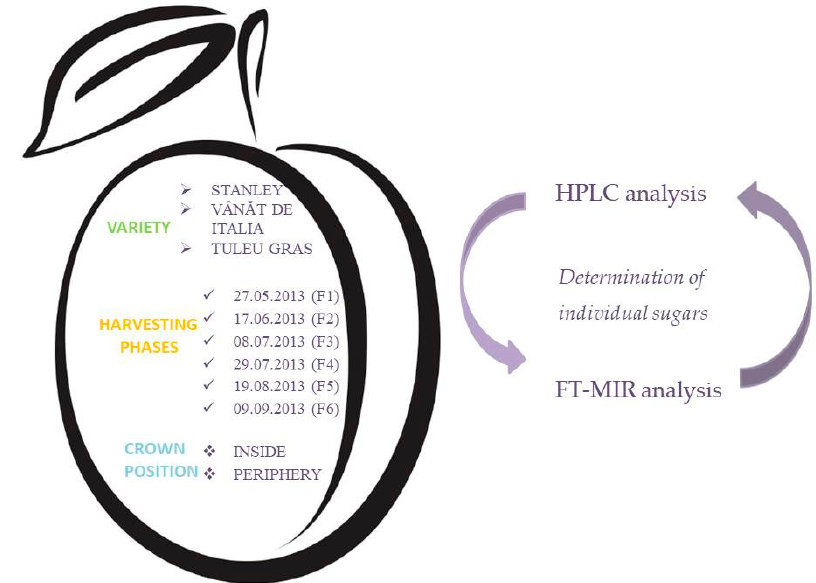
Figure 2. Experimental design. HPLC: High performance liquid chromatography; FT-MIR: Fourier transform mid-infrared spectroscopy.